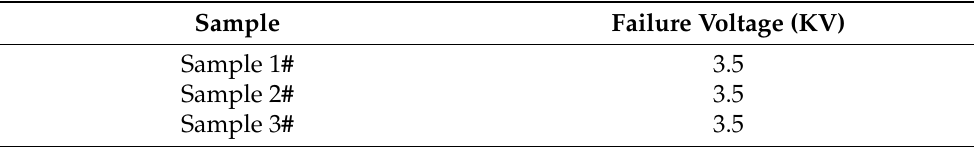
Table 5. HBM test results with NPL and drain contact